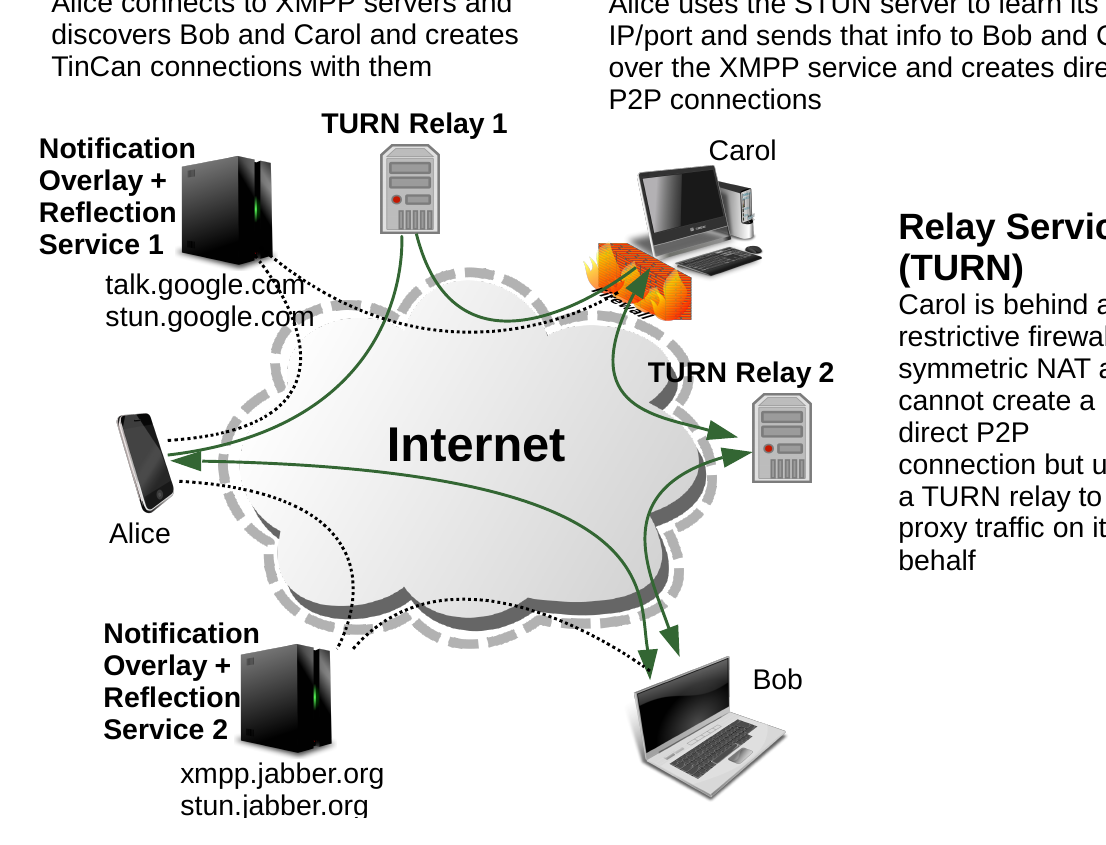
Figure 1. TinCan Components and